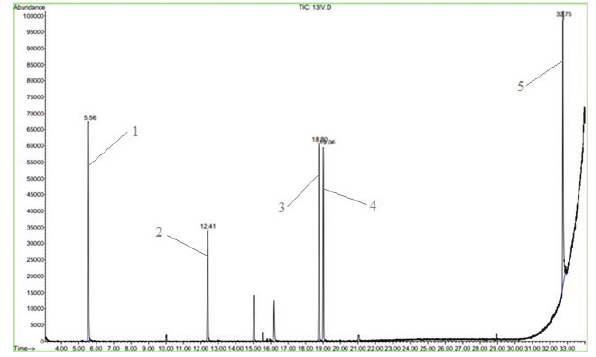
Figure 10. Chromatogram of free carbohydrates in the herbal mixture No. 19 (1 – arabinose, internal standard; 2 – glucose; 3–4 – fructose; 5 – sucrose).